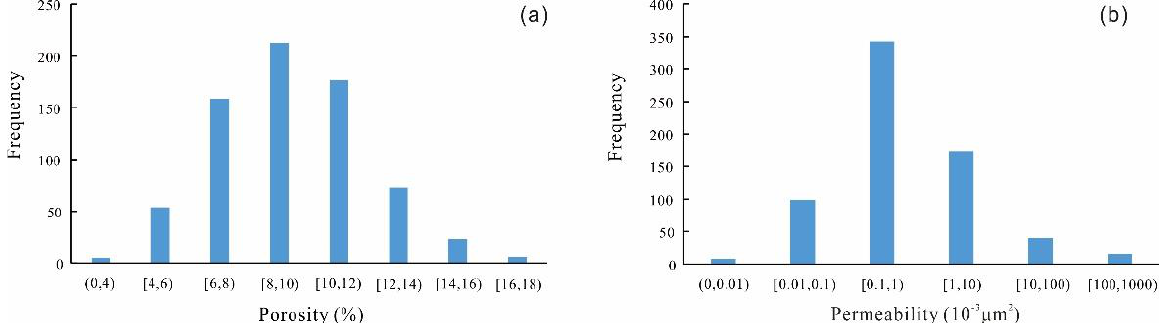
Figure 2. Distribution frequency histogram of porosity ( a ) and permeability ( b ) of Baikouquan formation.